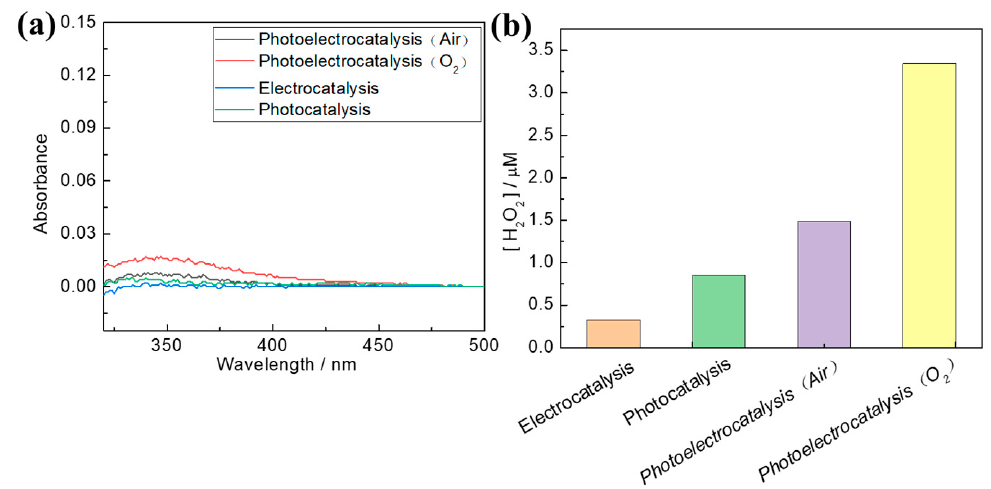
Figure 8. ( a ) UV–vis absorption spectra of molybdenum-triiodide indicator solution containing PEC cell solutions vs. PEC duration. ( b ) Production of H 2 O 2 over time during photoelectrocatalysis in